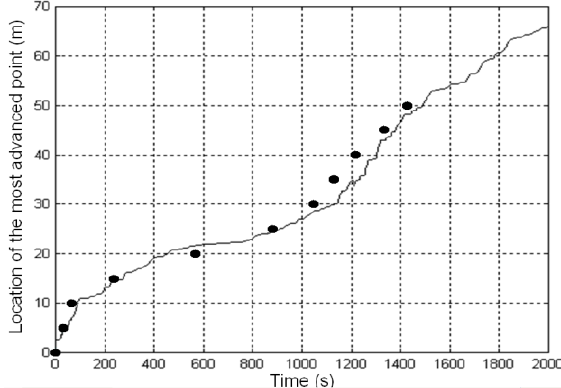
Figure 17. Temporal evolution of the most advanced point of the fire front obtained by the proposed measurement system and its comparison with manual